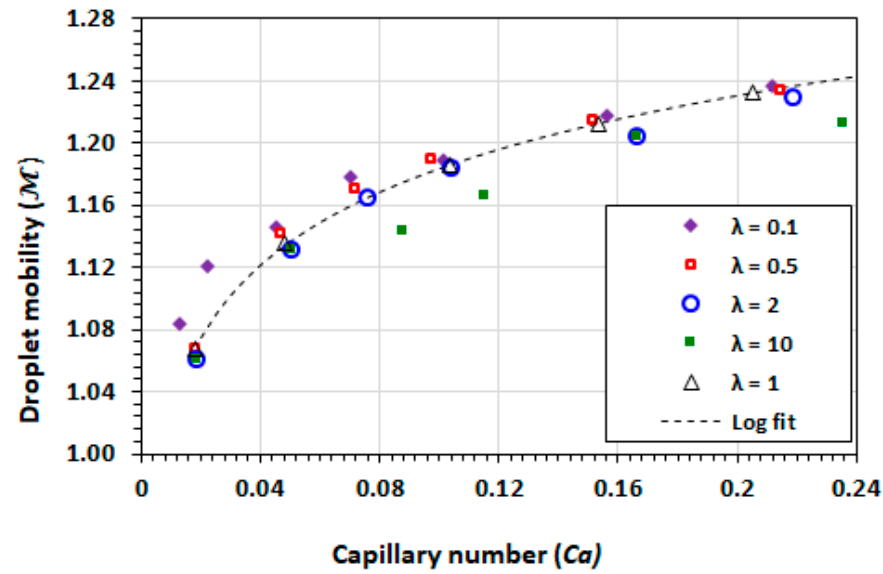
Figure 7. Plot of droplet mobility versus capillary number for different viscosity ratios.